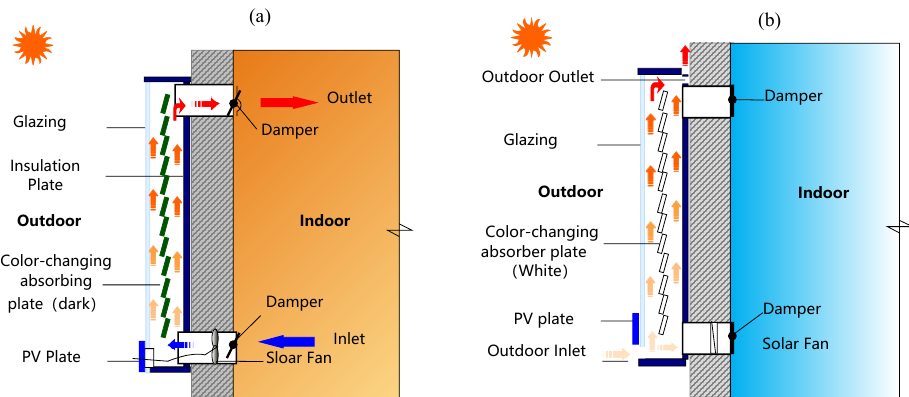
Figure 1. Operation principle ( a ) in winter ( b ) in summer. Reprinted with permission from ref. [43]. Copyright 2021 Elsevier.